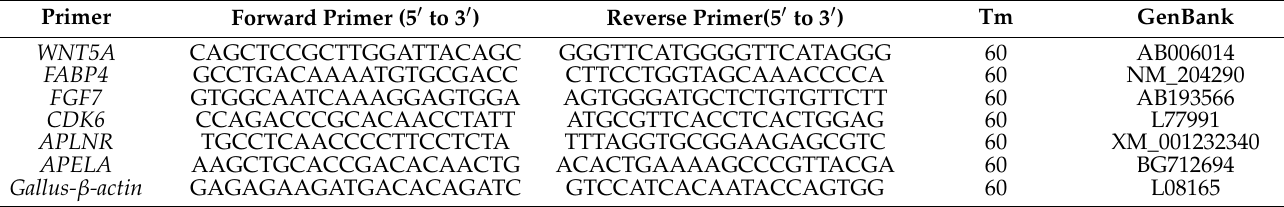
Table 3. Forward and reverse primers used for qPCR validation of RNA-seq.